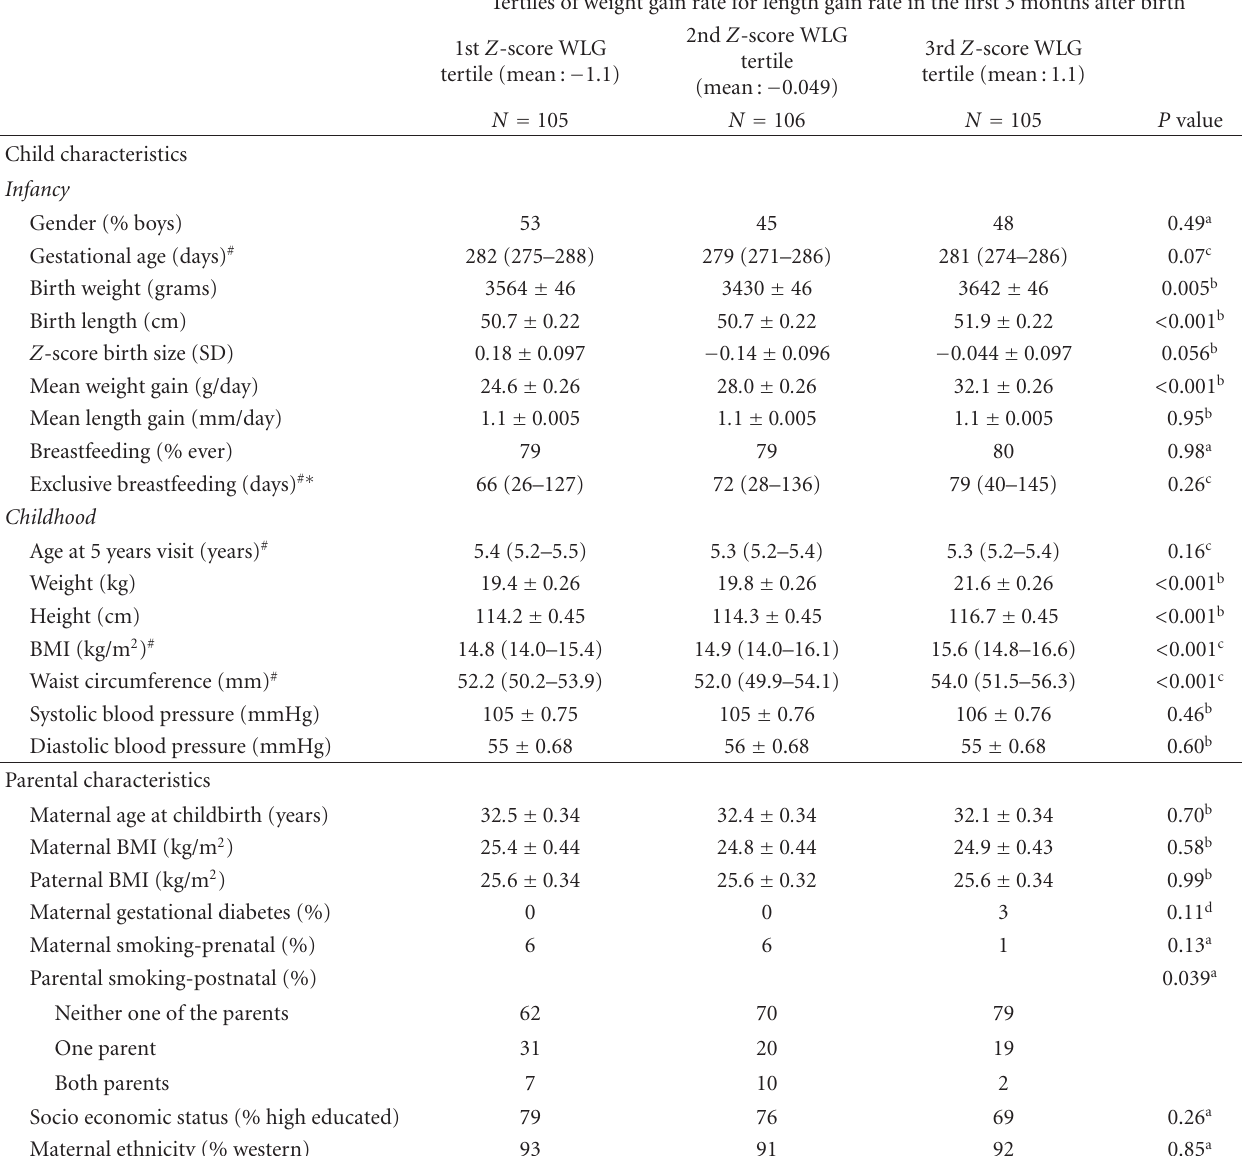
Table 1: Associations between child and parental characteristics and tertiles of Z -score weight gain for length gain rate in the first 3 postnatal